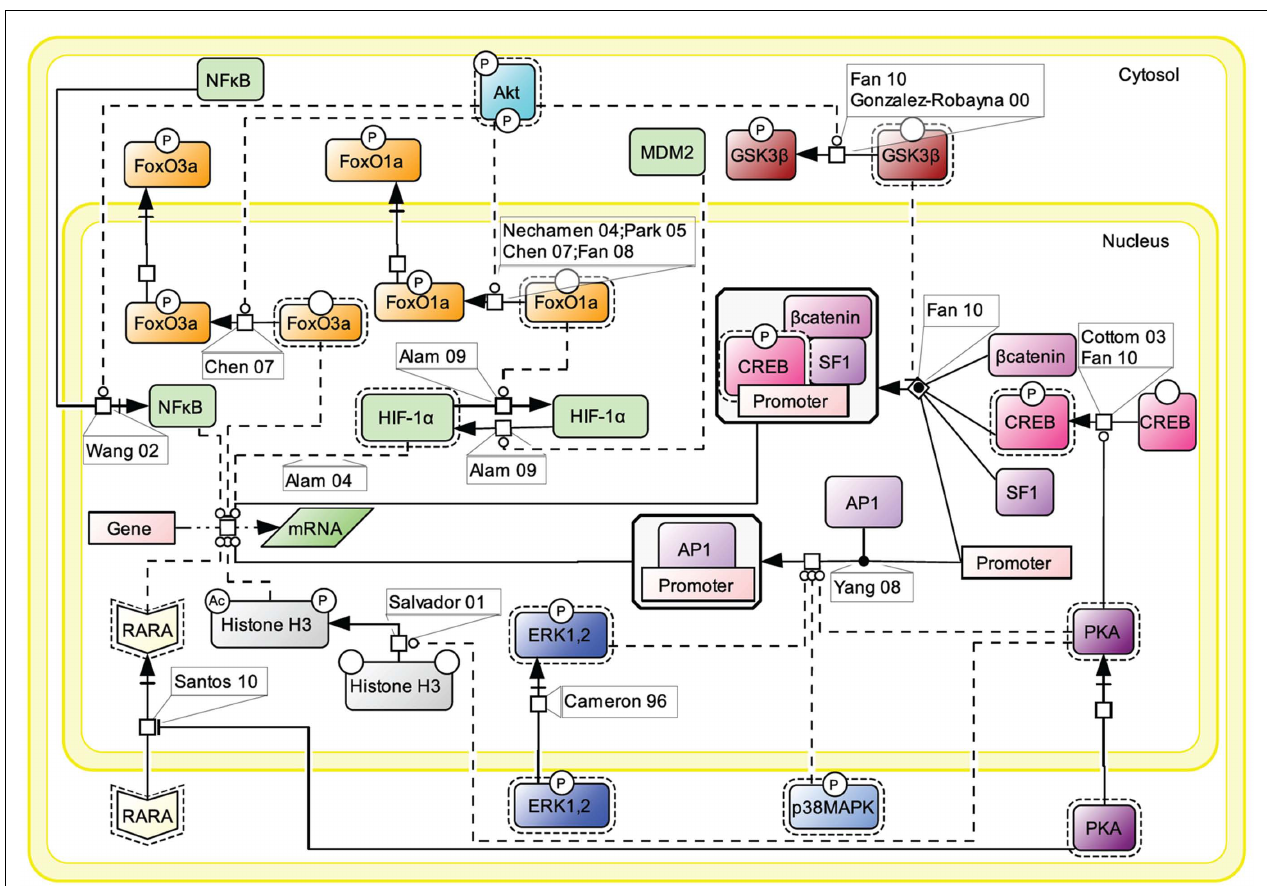
FIGURE 7 | Nuclear events controlled by FSH. Gene transcription has long been known to be affected by FSH. Multiple signaling pathways that are activated upon stimulation (i.e., PKA, p38, ERK, and Akt) subsequently trigger the activation or suppression of various transcription factors’ activities at the nuclear